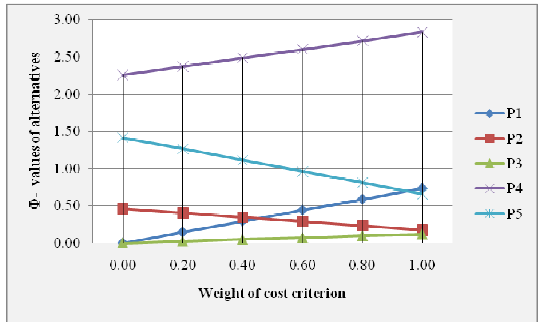
Figure 9. The change in the Φ - values of alternatives with the change in the weight of cost criterion When considering the net flows, with the increase of the weight of cost criterion from “0” to “1”, the net flows of P1, P3 and P4 are getting worse, and the net flows of P2 and P5 are getting better (Figure 10). This is why, P1, P3 and P4’s evaluations for cost criterion are below the average when comparing with the others and the increase on the cost criterion’s weights amplifies this situation. This situation is parallel to the analysis of the sensitiveness of Φ + and Φ - values to the weight of the cost criterion.